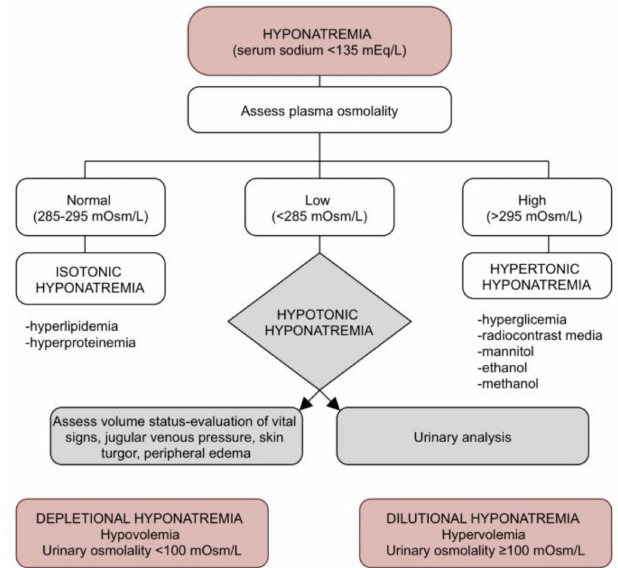
Figure 3. Diagnosis algorithm in heart failure associated